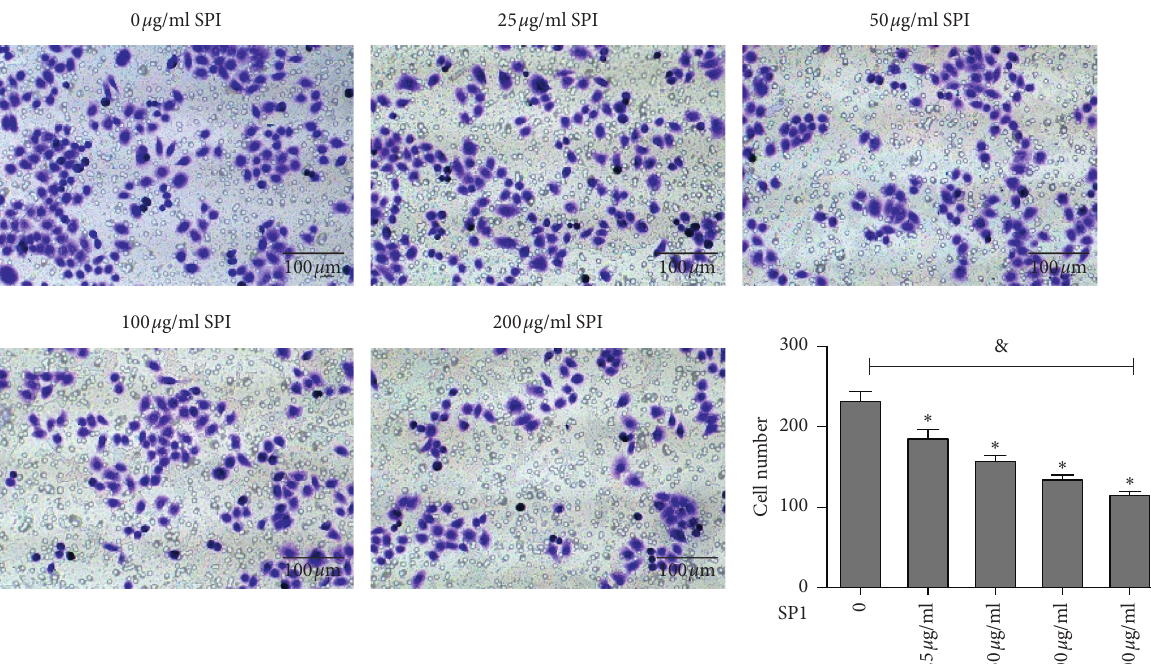
Figure 5: The invasion ability of MGC-803 cells treated with different concentrations of SP1 (0, 25, 50, 100, and 200 μ g/ml) for 72h was detected by transwell assay. Compared with 0 μ g/ml SP1-treated (control) group, ∗ P < 0 . 05; & P < 0 . 05 for comparison between groups under different concentrations of SP1 treatment.